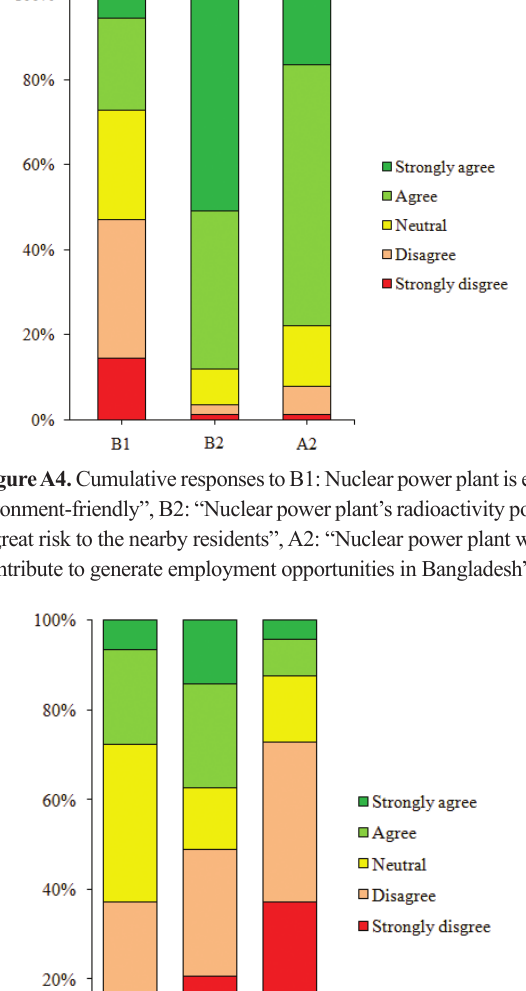
Figure A8. Gender-wise responses to K10 and A5.